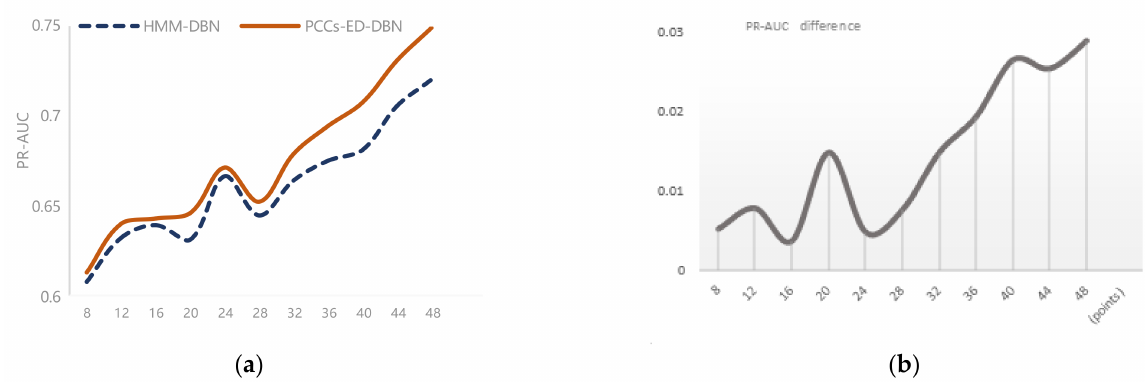
Figure 9. PR-AUC of synthetic dataset. Panel (a) shows the network reconstruction accuracy in terms of PR-AUC scores at different data point lengths. Panel (b) shows the difference in network reconstruction accuracy in terms of PR-AUC scores at different data point lengths.